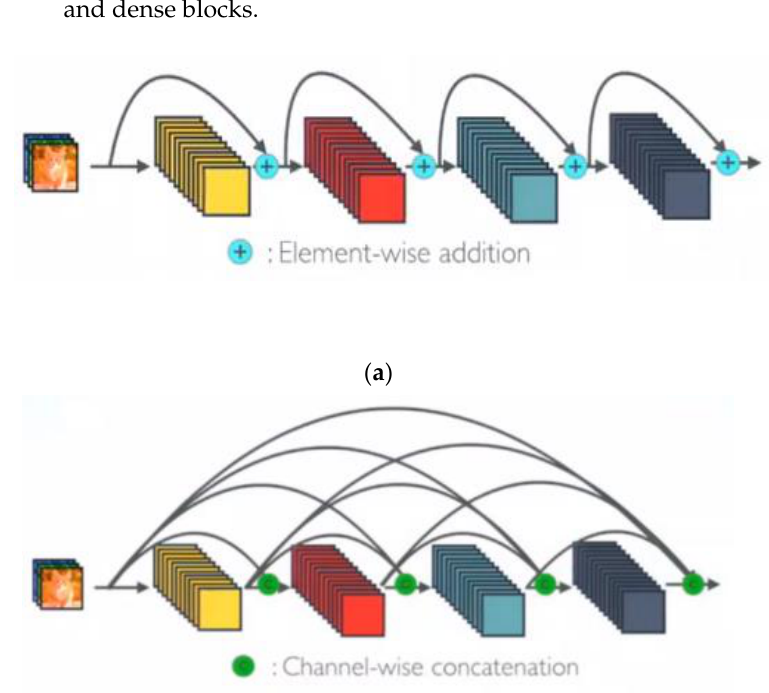
Figure 13. ( a ). ResNet Concept, ( b ). One Dense Block in Dense Net